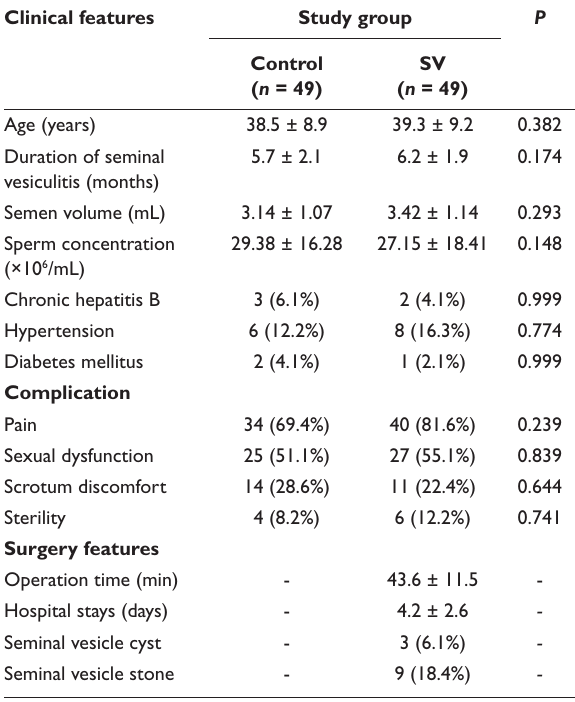
Table 1. Demographic and clinical characteristics of the